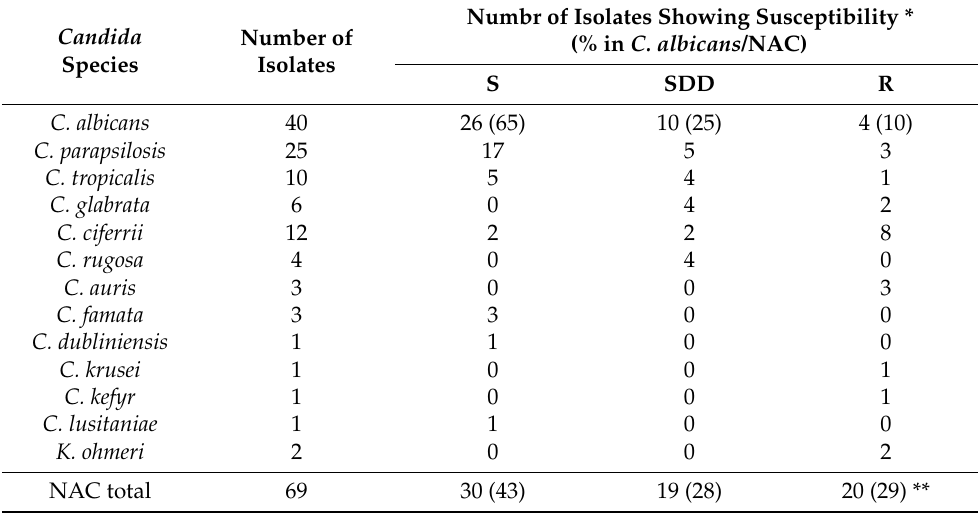
Table 2 shows susceptibility to fluconazole among all of the Candida isolates, based on MIC (the distribution of the MIC values is shown in Table S2). Although most C. albicans isolates were susceptible or susceptible dose dependent (SDD), NAC exhibited significantly higher resistance rates (overall, 29%) than C. albicans (10%). Among NAC, fluconazole resistance was detected in eight species, among which C. ciferrii , C. auris , and K. ohmeri showed higher resistance rates (>67%) than other species, except for the intrinsically resistant C. krusei . Table 2. Susceptibility to fluconazole among C. albicans and NAC. Numbr of Isolates Showing Susceptibility * Candida Number of (% in C. albicans /NAC) Species Isolates